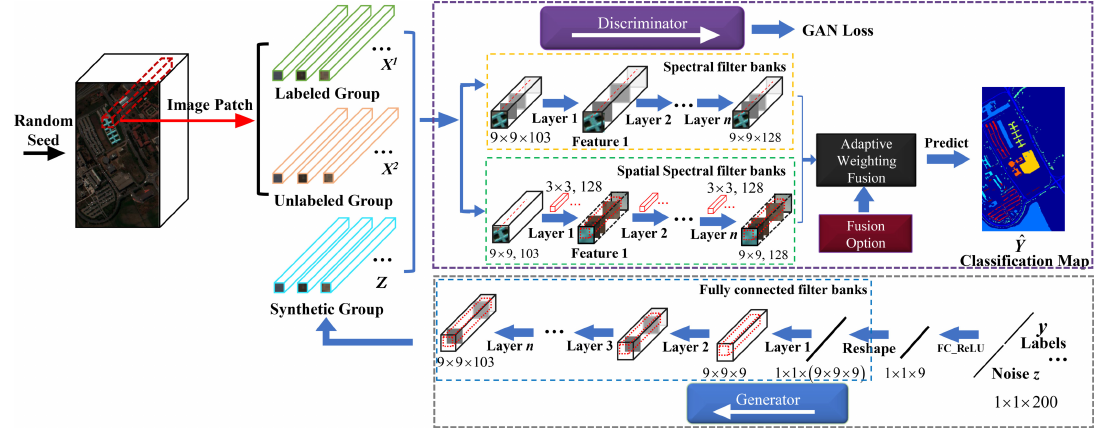
Figure 2. Framework of the AWF 2 -GAN for HSI